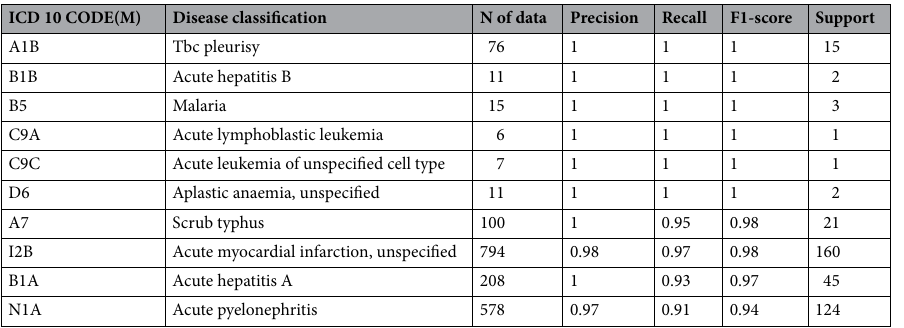
Table 1. Neural network (DL) model TOP 10 result using accuracy performance measure. M